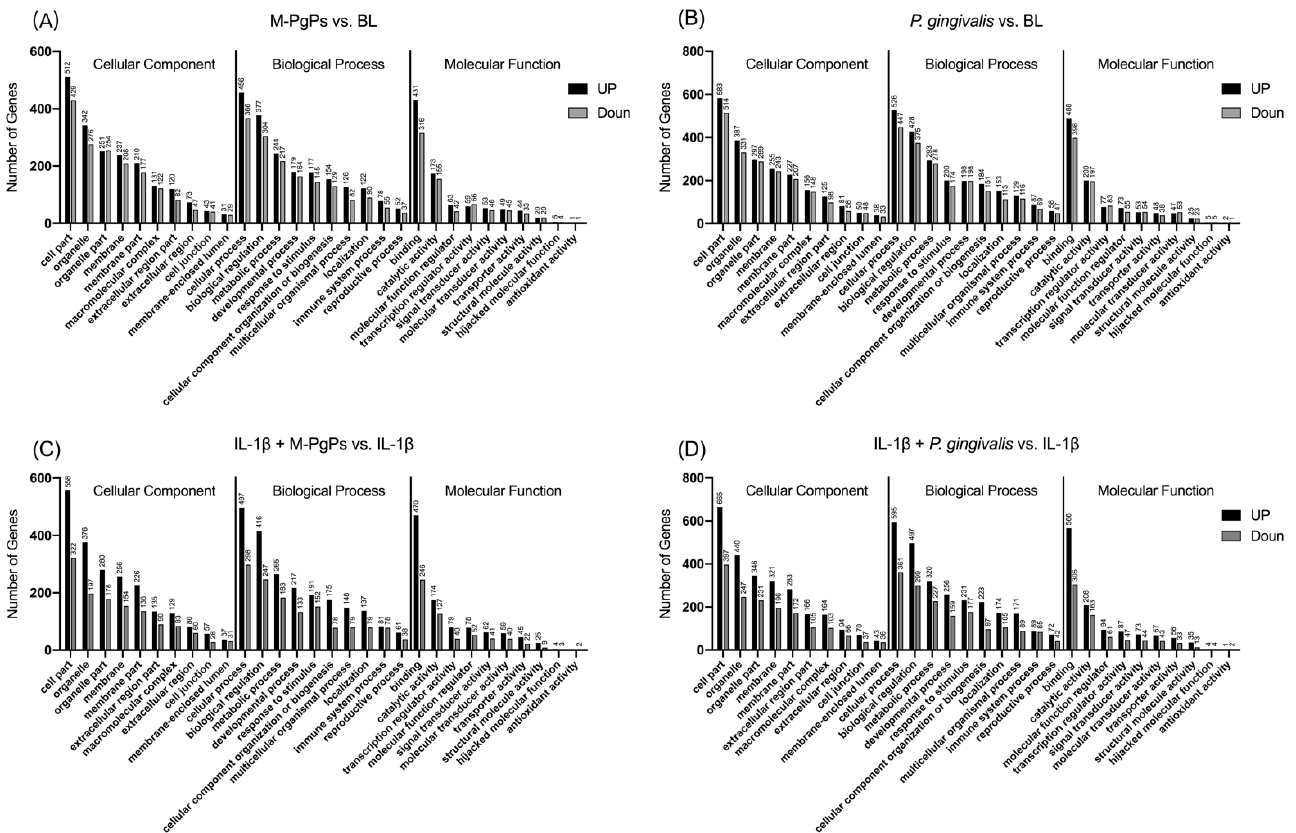
Figure 2. Gene Ontology functional annotation of DEGs in different comparison groups. The top 10 terms of GO functional annotation assigned from the DEGs in different comparison groups are shown. M-PgPs vs. BL ( A ); P. gingivalis vs. BL ( B ); IL- 1β + M -PgPs vs. IL- 1β ( C ); and IL- 1β + P. gingivalis vs. IL- 1β ( D ). GO terms are shown on the x axis. Numbers of DEGs enriched in the terms are shown above the bar. Black bar: upregulated genes. Gray bar: downregulated genes. Samples for RNA-Seq were obtained from three independent experiments.